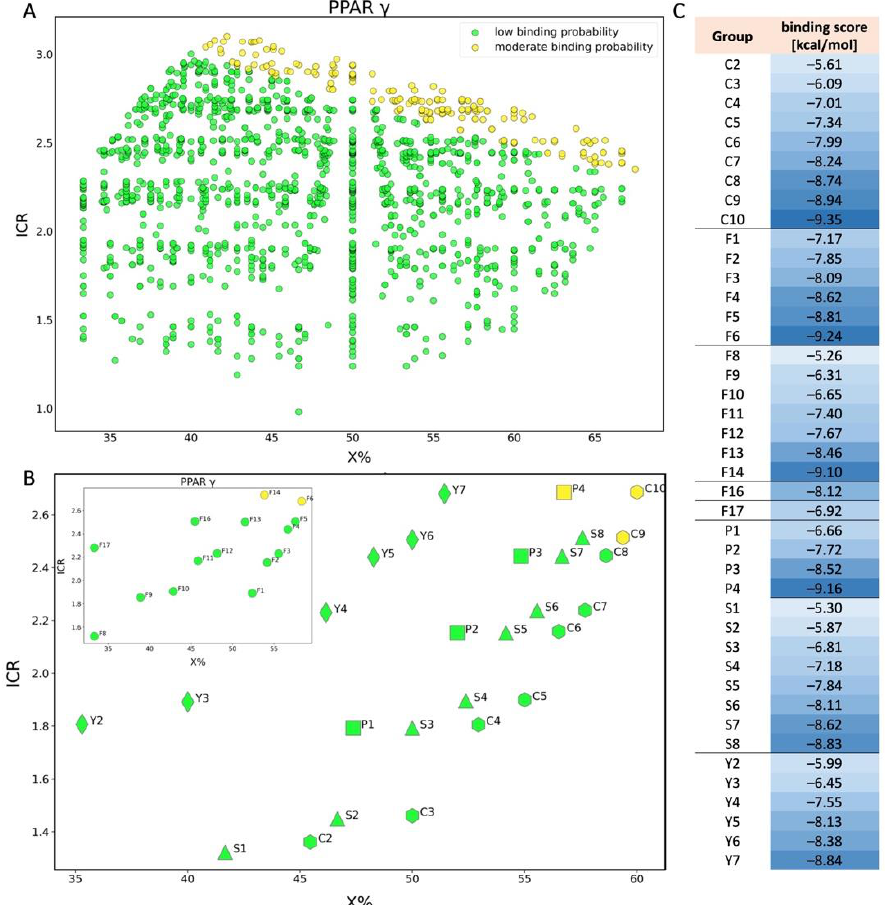
Figure 7. Scatter plot of binding scores obtained for PPAR γ in X% and ICR space ( A ); scatter plot for PPAR γ showing the division of PFAS into 5 different structural groups in space of X% and ICR. C-carboxylic acids (COOH-(CF2)n-CF3), S-sulfonic acids (SO3H-(CF2)n-CF3), P-phosphonic acids (PO3H2-(CF2)n-CF3, F-Fluorotelomer alcohol (F1-F7 (OH-(CH2)-(CF2)n-CF3), F8 – F14 (OH-(CH2)2-(CF2)n-CF3), F16 (OH-(CH2)3-(CF2)n-CF3), F17 (OH-(CH2)4-(CF2)n-CF3)), Y-dicarboxylic acids (COOH-(CF2)n-COOH). Colors: green-low binding probability, yellow-moderate binding probability ( B ); table showing binding score values for each compound shown in chart B ( C ).